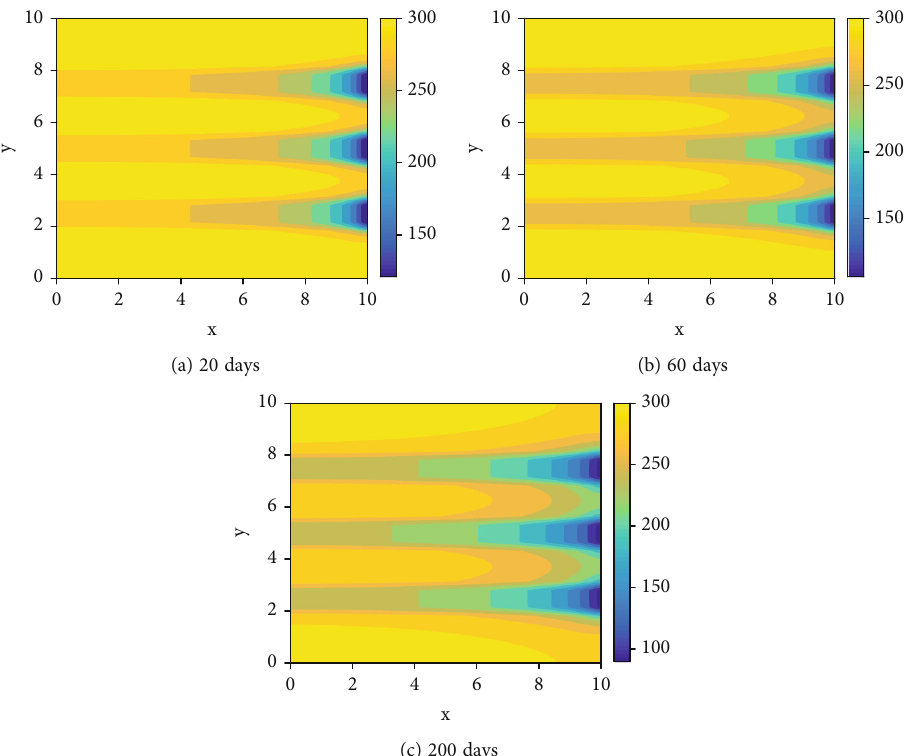
= 20 mol/m 3 at di ff erent b